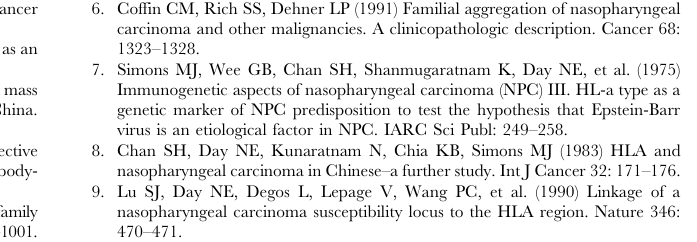
binding groove. All figures were prepared with PyMOL [14]. Table S1 NPC associated classical HLA class I alleles. Table S2 Sample and SNP filtering for this study.